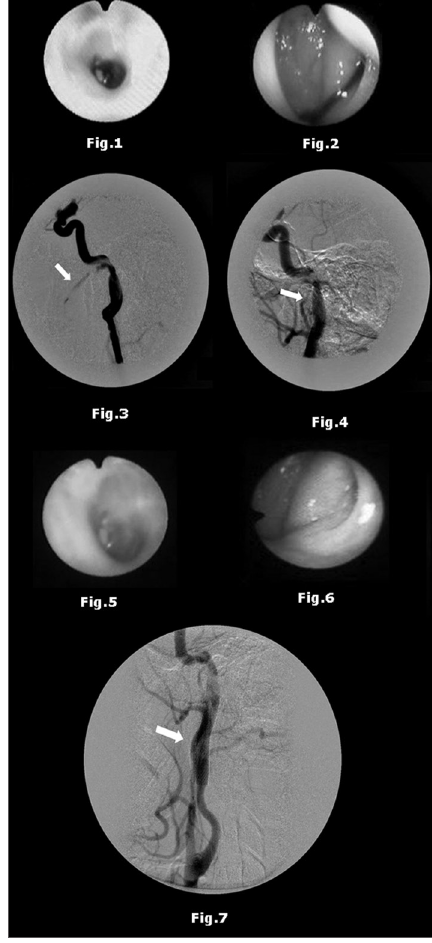
Figura 1. Otoscopia - Hemotímpano. Figura 2. Fibronasoendoscopia - Presença de sangue fluindo pela tuba auditiva. Figura 3. Angiografia cerebral antes da implantação dos stents - Imagem de rotura arterial no segmento petroso da ACI esquerda com extravasamento de contraste para a nasofaringe. Figura 4. Angiografia cerebral após implantação dos stents - Ausência de extravasamento de contraste da ACI esquerda para a nasofaringe. Figura 5. Otoscopia 45 dias após implantação dos stents - Re- missão quase total do hemotímpano. Figura 6. Fibronasoendoscopia 45 dias após a implantação dos stents - Ausência de sinais de sangramento pela tuba auditiva. Figura 7. Angiografia 45 dias após a implantação dos stents - Patência dos stents e ausência de sinais de extravasamento de contraste da ACI esquerda para a